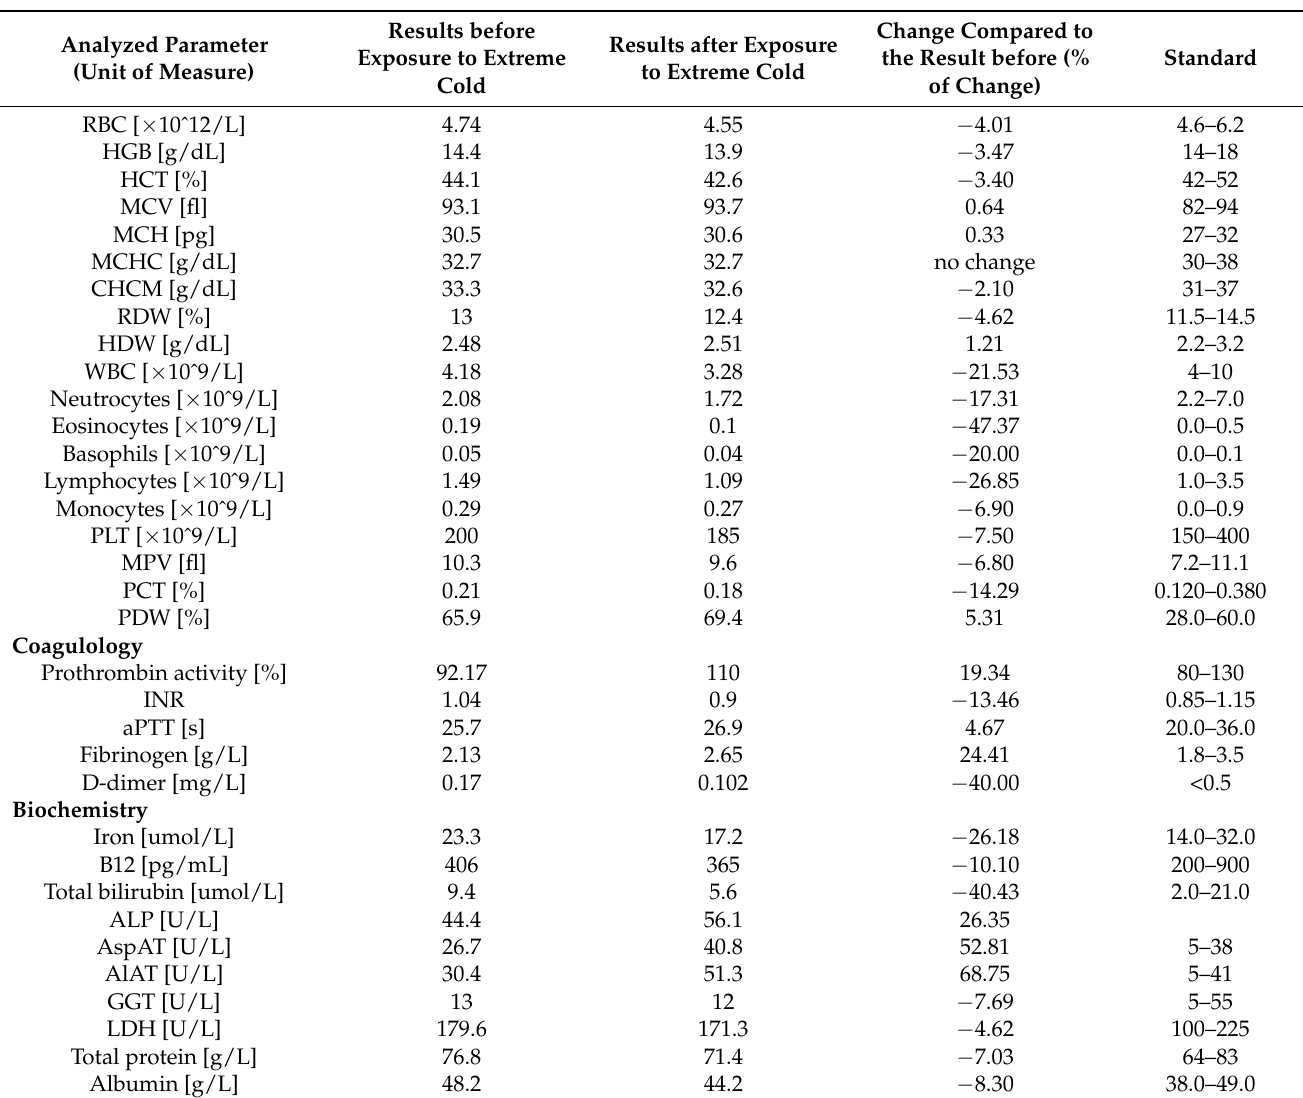
Table 3. Patient outcomes before and after prolonged exposure to extreme